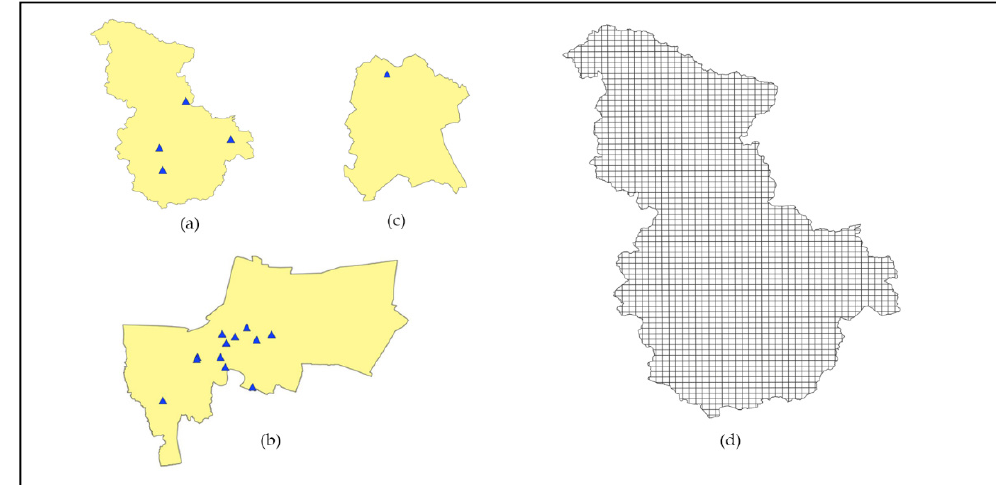
Figure 1. Study areas ( a – c ) show administrative boundaries, and triangle symbols show current stations. The map regions ( d ) divided into 2024 grid cells in Sejong city.